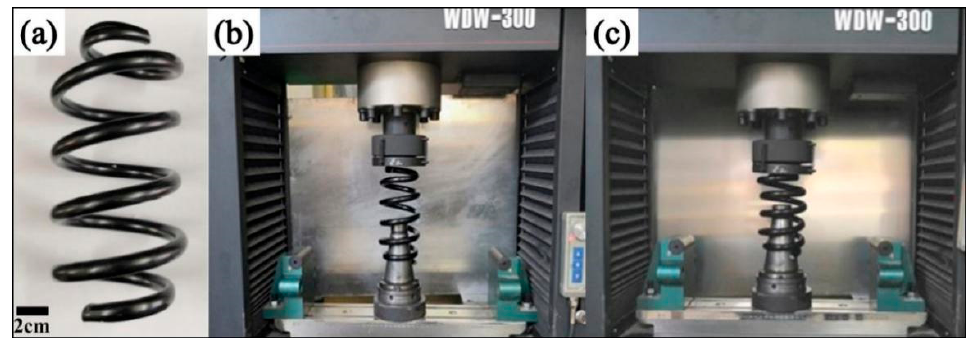
Figure 3. The HCS samples and test mechanism: ( a ) HCS samples; ( b ) test setup; ( c ) sample under